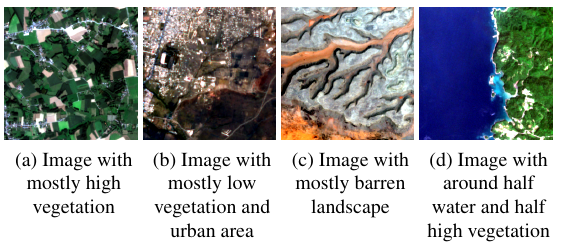
Figure 4. Example images from different regions with various landcover types. As can be seen from images, landcover is very distinct from region to